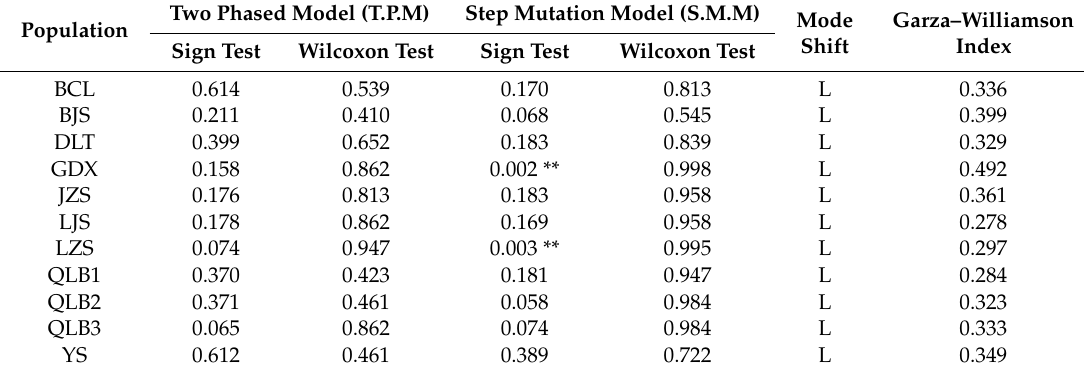
Table 6. Bottleneck analysis of 11 populations in R. rex subsp. rex.